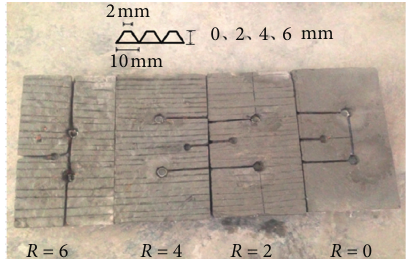
Figure 7: Concrete panels of different roughness.